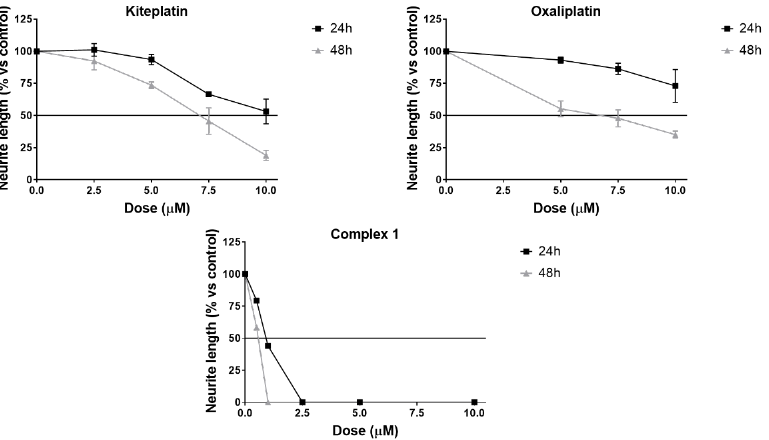
Figure 9. Toxicity in DRG explants. DRG explants from 15-day embryonic Sprague-Dawley rats were treated for 2 h with NGF and subsequently exposed to kiteplatin, oxaliplatin and complex 1 for 24 h or 48 h. Phase-contrast micrographs were taken, and the length of the longest neurite in each DRG was measured using a standard calibration grating photographed at the same magnifica-